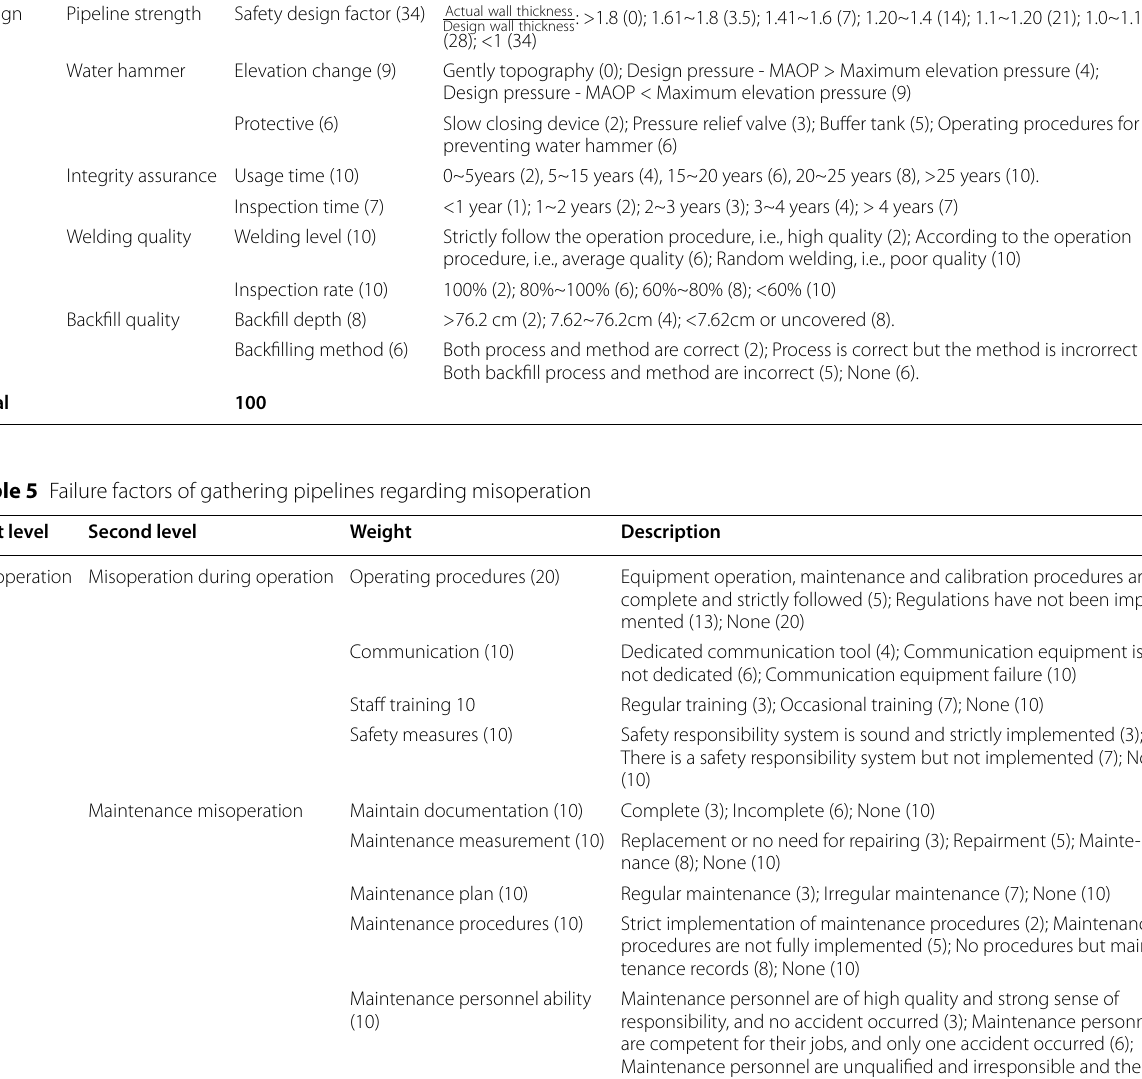
Table 4 Failure factors of gathering pipelines regarding design First level Second level Weight